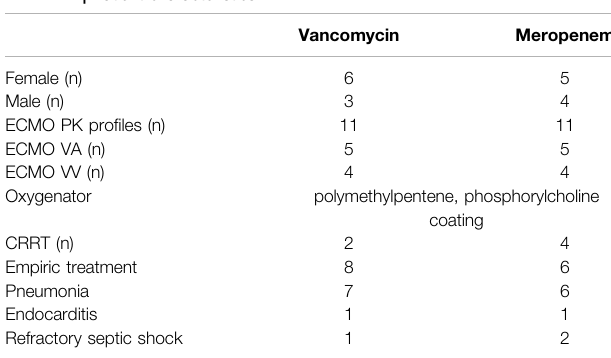
TABLE 1 | Patient